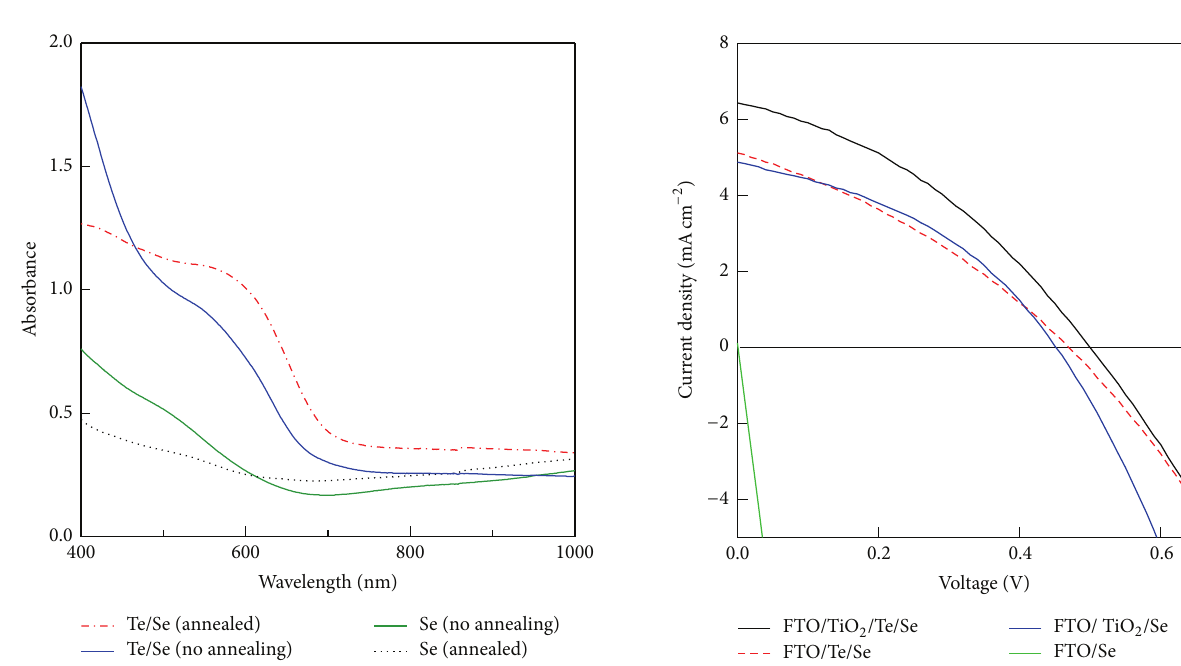
Figure 5: Absorption spectra of electrodeposited Se (with/without Te) layers on glass/FTO/TiO 2 substrates with and without annealing at 200 ∘ C for 3min.